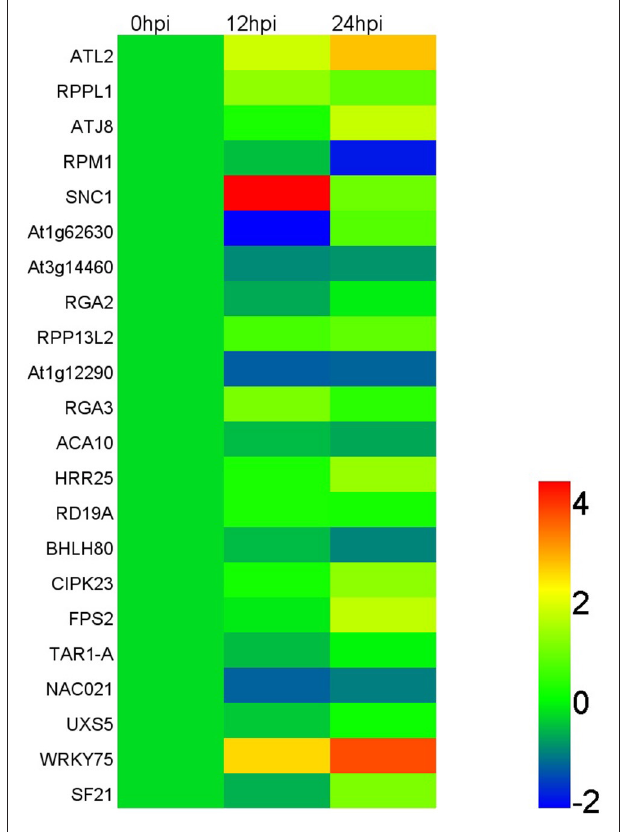
FIGURE 5 | Relative expression of the target genes in apple twig bark tissue— V. mali interaction. Twenty-two identified targets of miRNAs were selected for transcript accumulation analysis in apple twig bark tissue after challenge with V. mali (12 and 48 hpi). The data were normalized to the expression level of apple translation elongation factor 1 alpha-subunit (EF). The relative expression level of the miRNAs in the V. mali -inoculated plants at each time point was calculated as the fold-change of the mock-inoculated plants at that time point using the comparative 2 − 11 CT method. The value of Log2 fold-change is used to construct the heat map. Different colors indicate the relative expression level of different target genes during the infection progress of Vm to apple